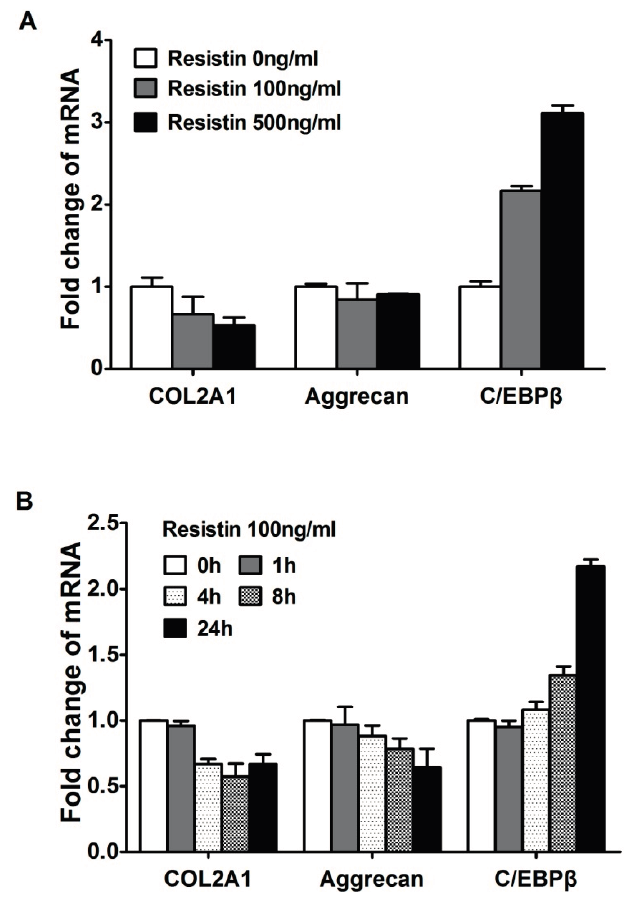
Figure 2. Resistin stimulates the expression of C/EBP β in normal human articular chondrocytes (HACs). The relative expression levels were examined in normal chondrocytes from human articular cartilage treated with resistin for various doses and times using quantitative real time PCR method. ( A ) Cells were treated with various concentrations of resistin for 24 h as indicated in HACs; ( B ) Cells were treated with 100 ng/mL resistin for various times as indicated in HACs. Each bar represents the mean ± S.D. from three